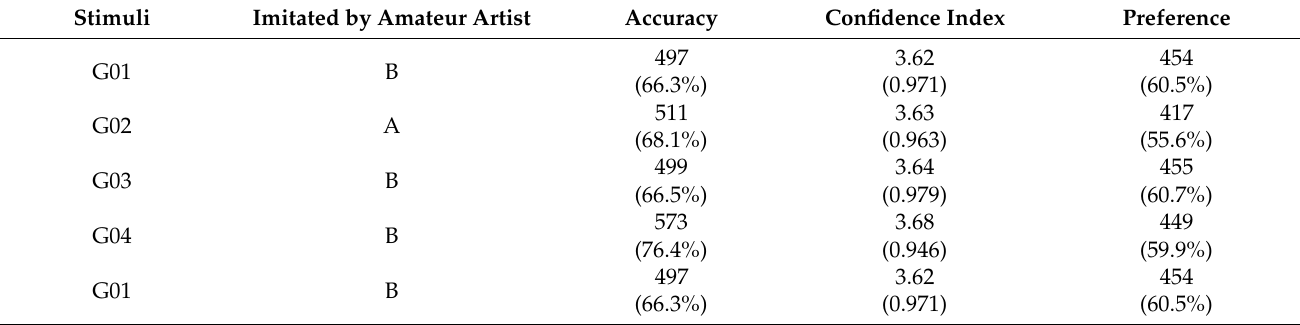
Table 2. The accuracy, confidence index and the preference for G01–G06.